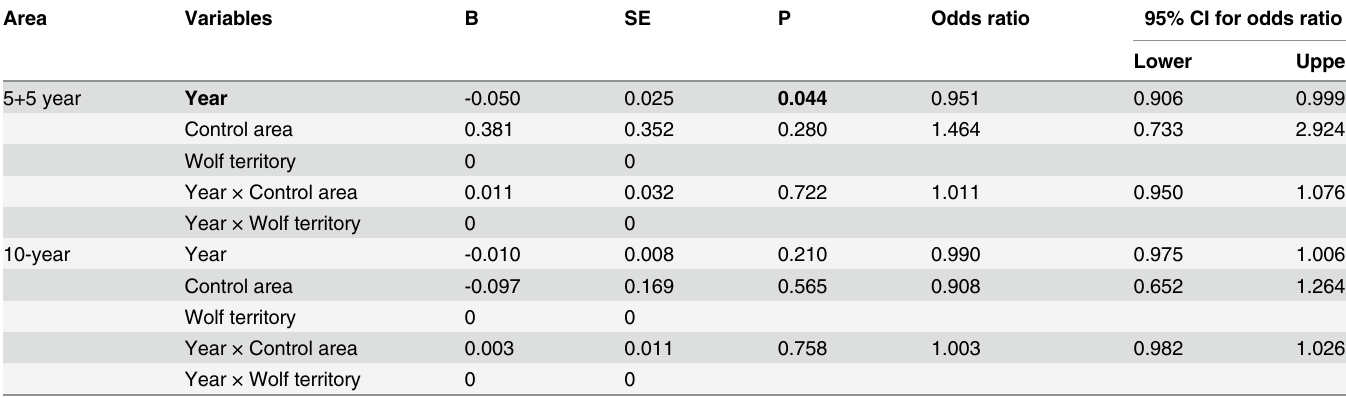
Table 5. Parameter values (B) of year and type of area (wolf territories and control areas) on hunting effort, using a generalized linear mixed model.